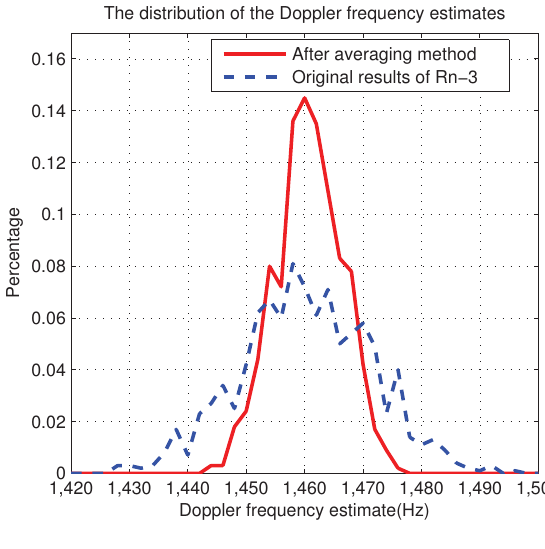
Figure 11. The distribution of the Doppler frequency